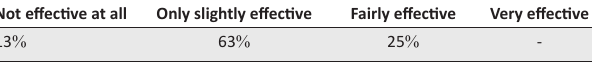
TABLE 6: Perceived effectiveness of available tax incentives relating to energy efficiency or renewable energy in South Africa. Not effective at all